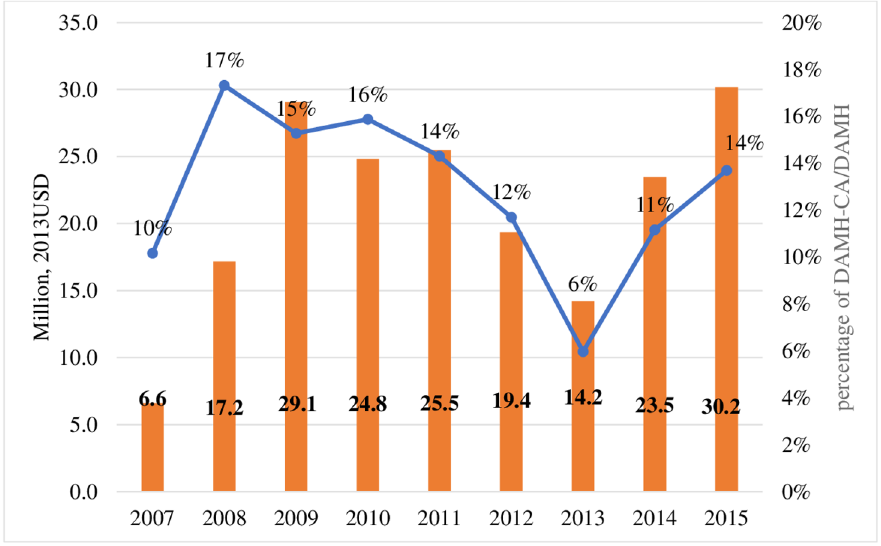
Fig 1. DAMH_CA by year (million, 2013 USD) and DAMH_CA disbursements as percentages of total DAMH, lower-bound estimates. DAMH, development assistance for mental health; DAMH_CA, development assistance for child and adolescent mental health, USD, US